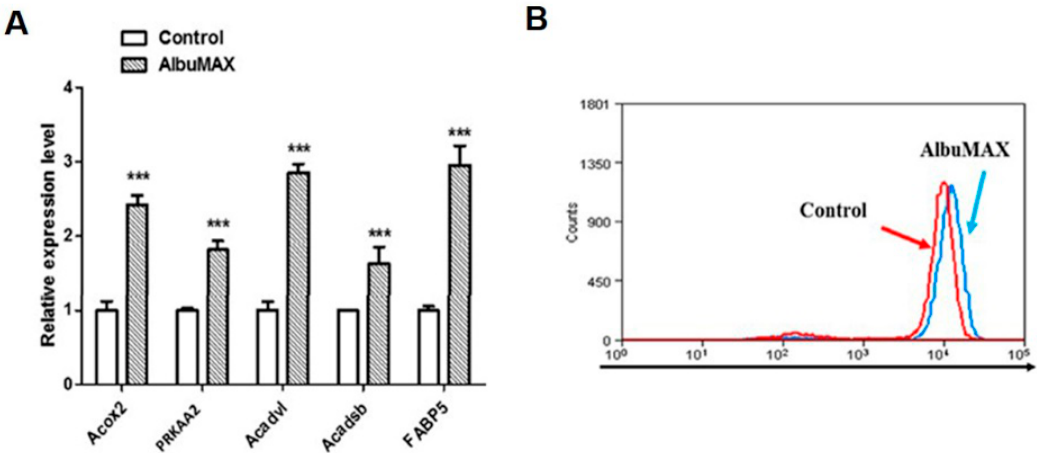
Figure 4. AlbuMAX facilitates lipid droplets accumulation. ( A ) Quantitative RT-PCR analyzed the expression of fatty acid metabolism related genes. *** p < 0.001; ( B ) Analysis of lipid droplets content in iPSCs by flow cytometry.